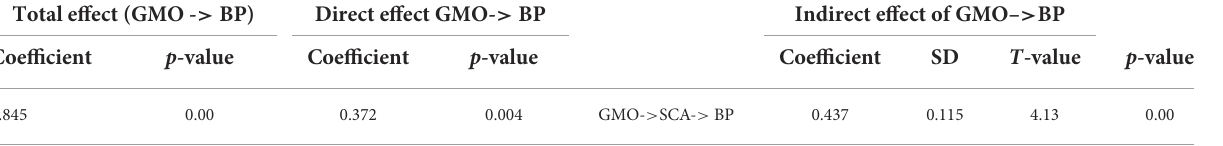
TABLE 5 Summary of mediation